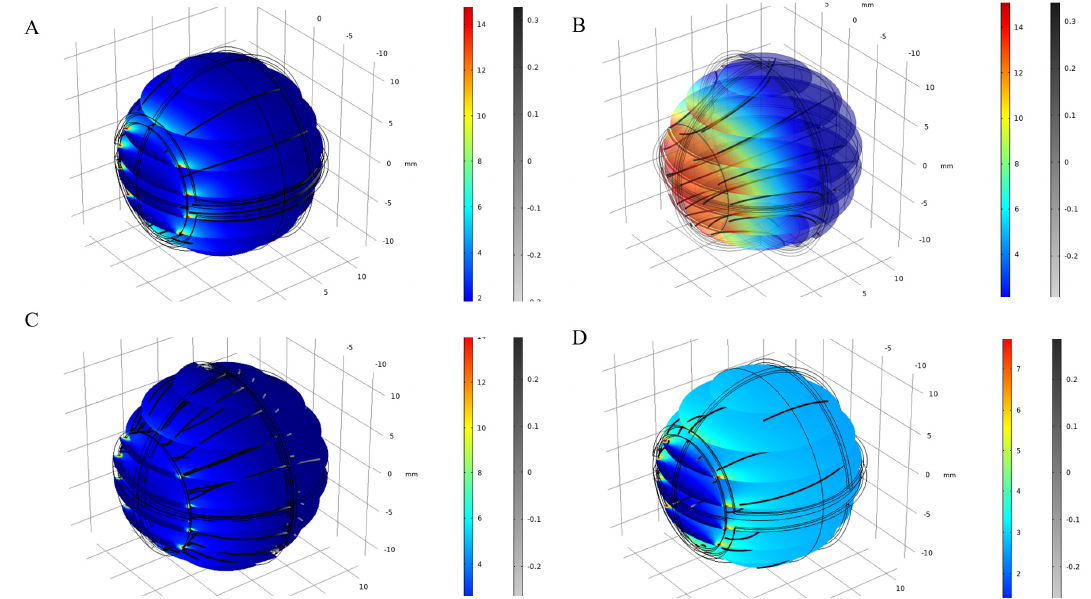
Figure 8. COMSOL Multiphysics Model simulation of drug entry routes originating from ( A ) the subconjunctival, ( B ) topically, ( C ) the vitreous and ( D ) the subretina and penetrating into the vitreous. The concentration profile is demon- strated using both streamline and slices. The right color bar represents the concentration spectrum for the streamlines and the left represents the slices.